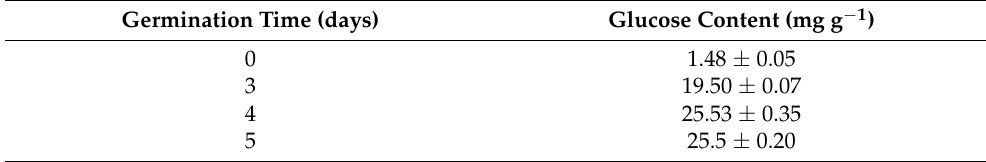
Table 2. Glucose content in the barley seeds at distinct germination